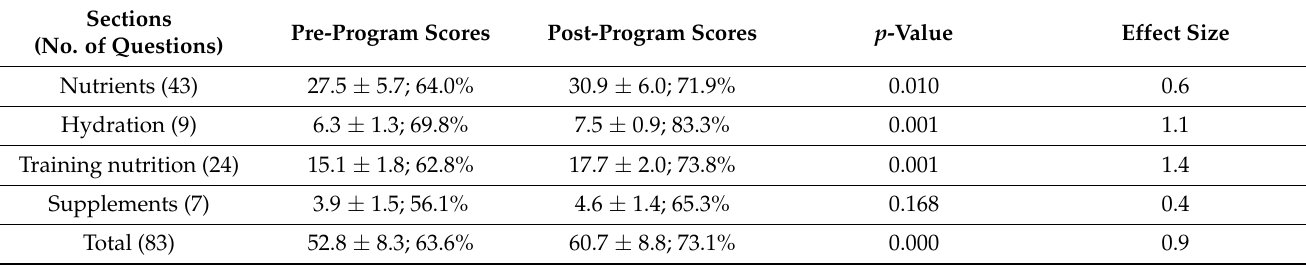
Table 2. Sports Nutrition Knowledge Questionnaire (SNKQ) scores of junior elite triathletes (mean ± SD; % correct scores) before and after the 8-week nutrition education program ( n = 14).